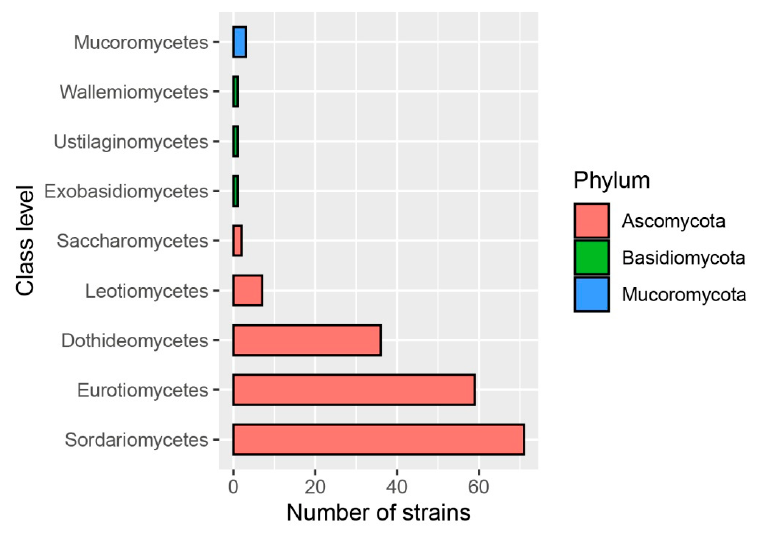
Figure 2. The number of fungal strains belonging to different classes that were isolated from intertidal zones of Qingdao.